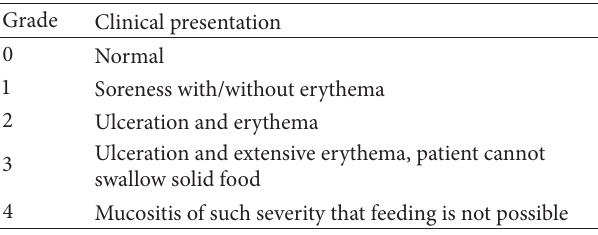
Table 1: WHO oral mucositis scale